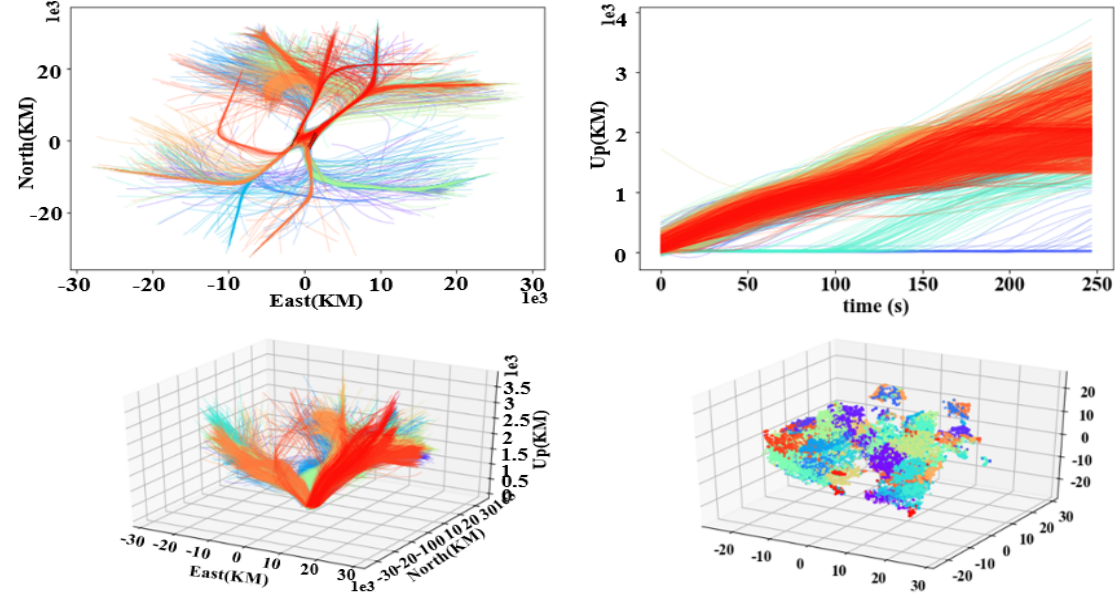
Figure 9. Visualization of clustering results of departure trajectories.